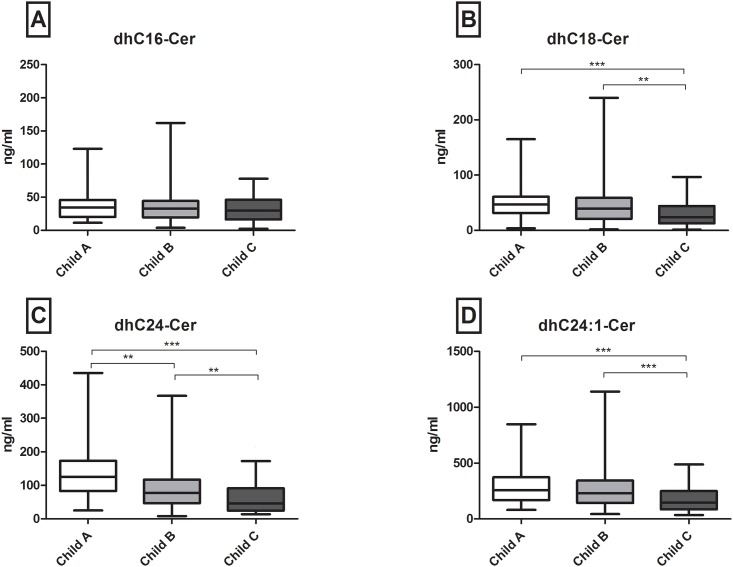
Severity of cirrhosis associates with a decrease of serum dhCer levels.Patients with Child C cirrhosis have significantly lower serum dhCer concentrations as compared to Child A (p<0.001 for dhC18-, dhC24- and dhC24:1-Cer) and Child B cirrhosis (p<0.01 for dhC18- and dhC24-Cer and p<0.001 for dhC24:1-Cer). Only dhC24Cer levels show a significant difference between Child A and Child B cirrhosis (p<0.01). Pairwise comparisons were used as post hoc analysis for significant overall differences. dh: dihydro, Cer: ceramide.